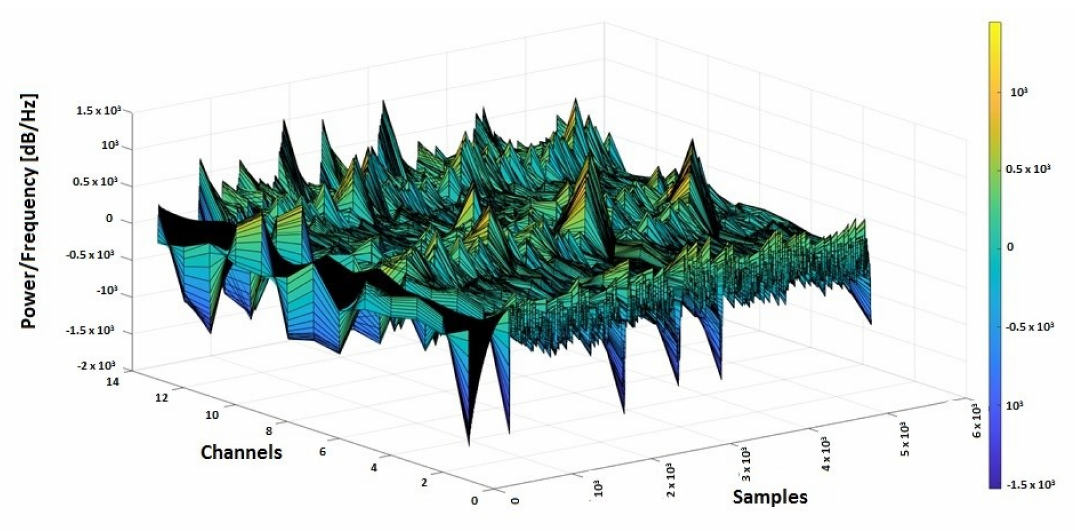
Figure 6. 3D spectrogram of signals EEG from 13 channels for patient n1 with no epileptic seizures.